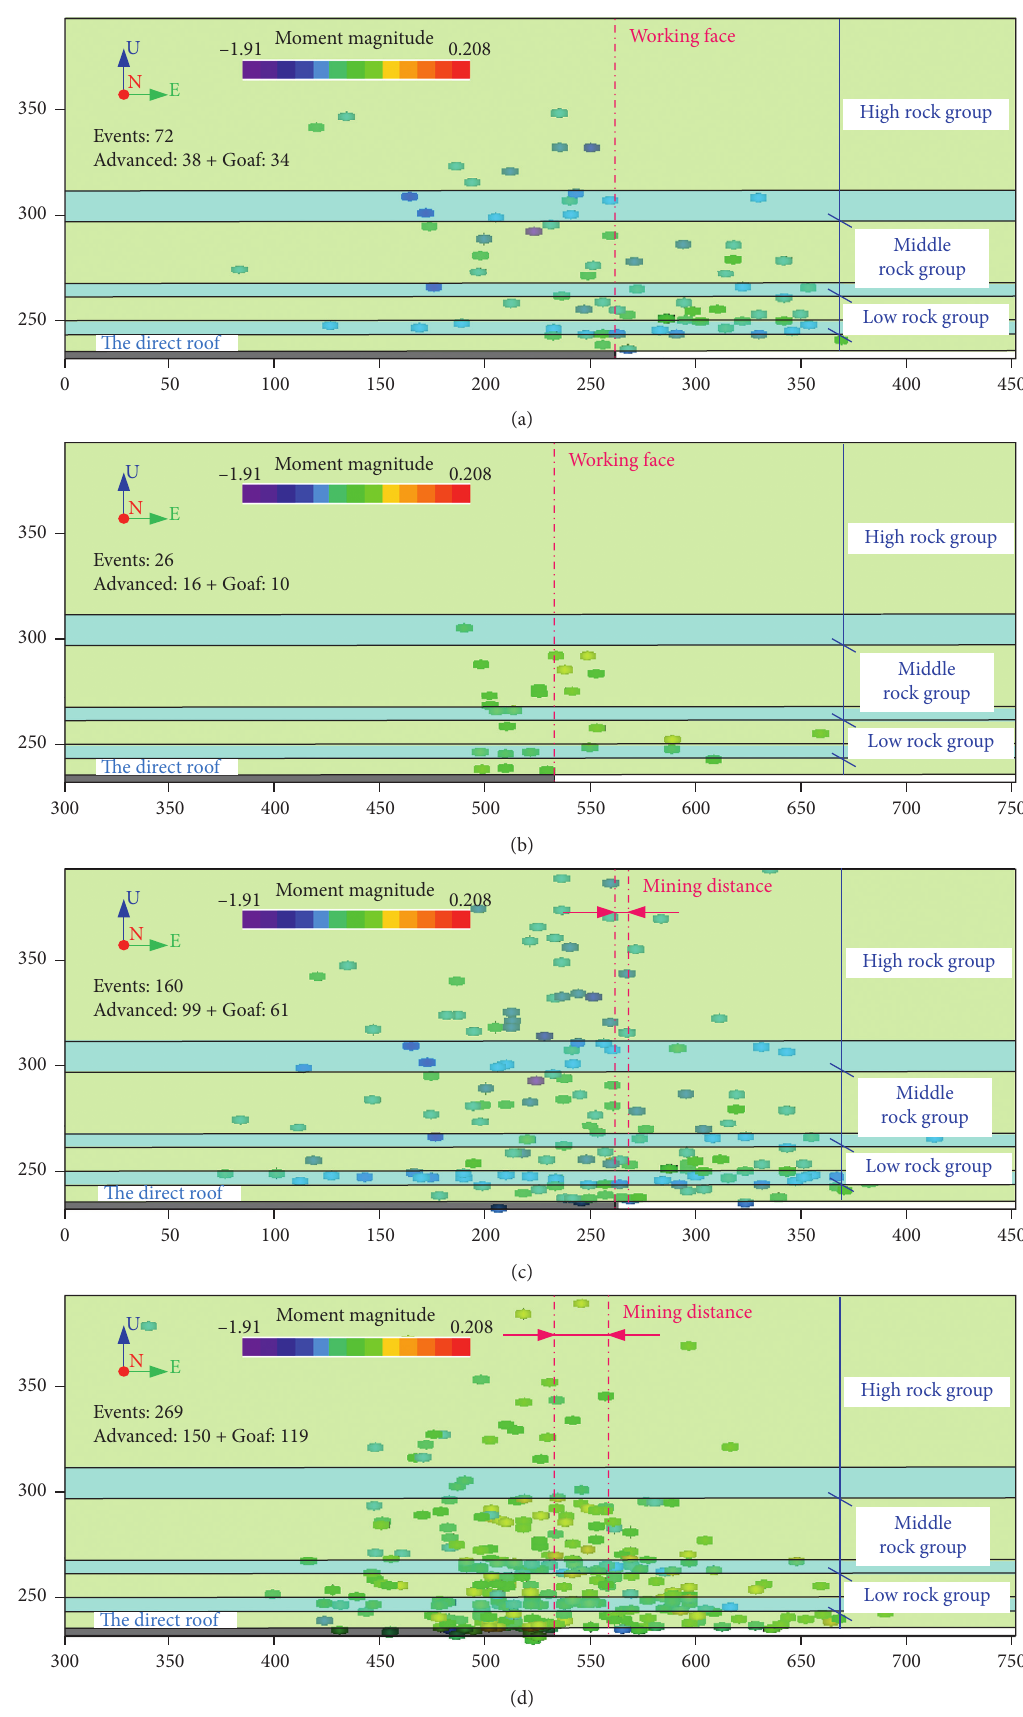
Figure 3: Characteristics of microseismic activity under different advancing speeds. (a) 2016.04.14 ∼ 2016.04.15 (slow advancing).